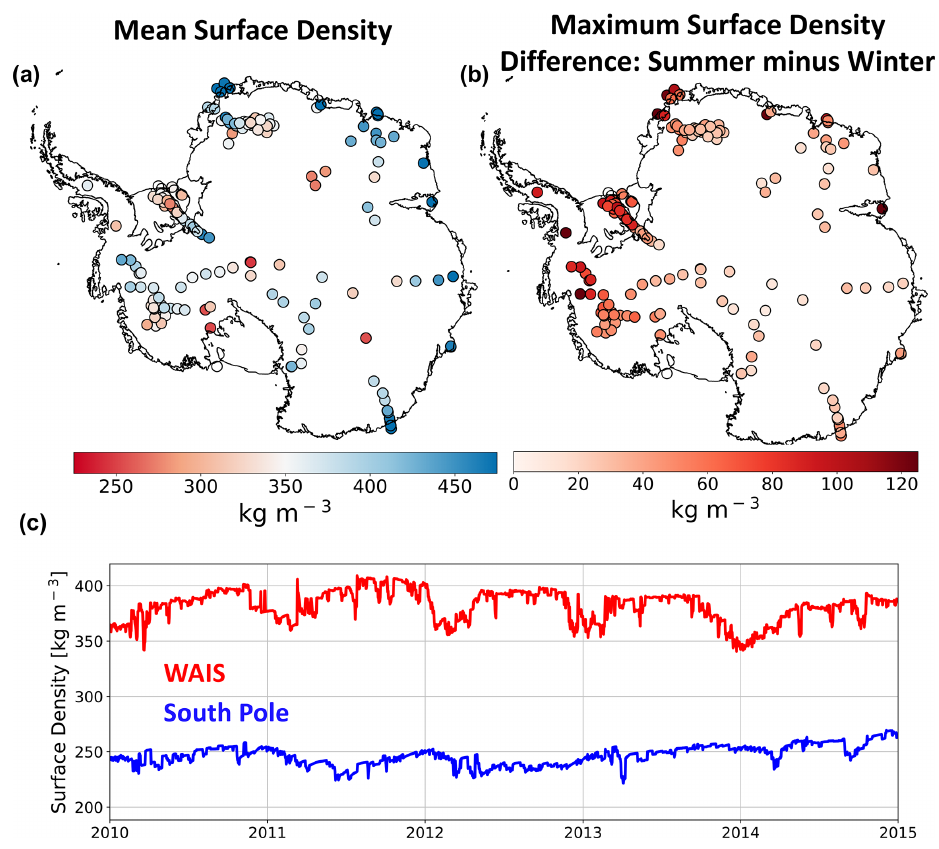
Figure 11. SNOWPACK-simulated surface snow density. Map of 1980–2017 mean SNOWPACK surface density (kgm − 3 , a ). Map of SNOWPACK-simulated surface density variability, defined as the 1980–2017 maximum difference between summer and winter mean surface density (kgm − 3 , b ). Time series of 2010–2015 SNOWPACK-simulated average surface density (kgm − 3 ) at the South Pole (blue) and WAIS (red, c